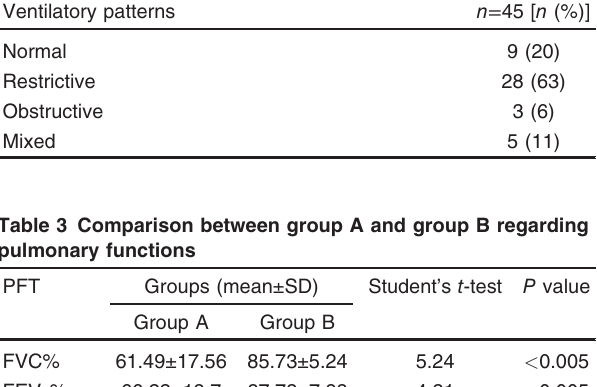
Table 2 Prevalence of ventilatory patterns in group A Ventilatory patterns Normal